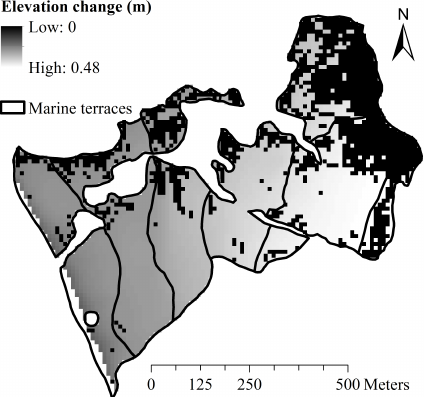
Figure 6. Simulated altitude change in the study area. A clear dif- ference is visible between ridge positions (black grid cells) and trough positions (grey shading), due to the absence of aeolian de- position on ridge positions.